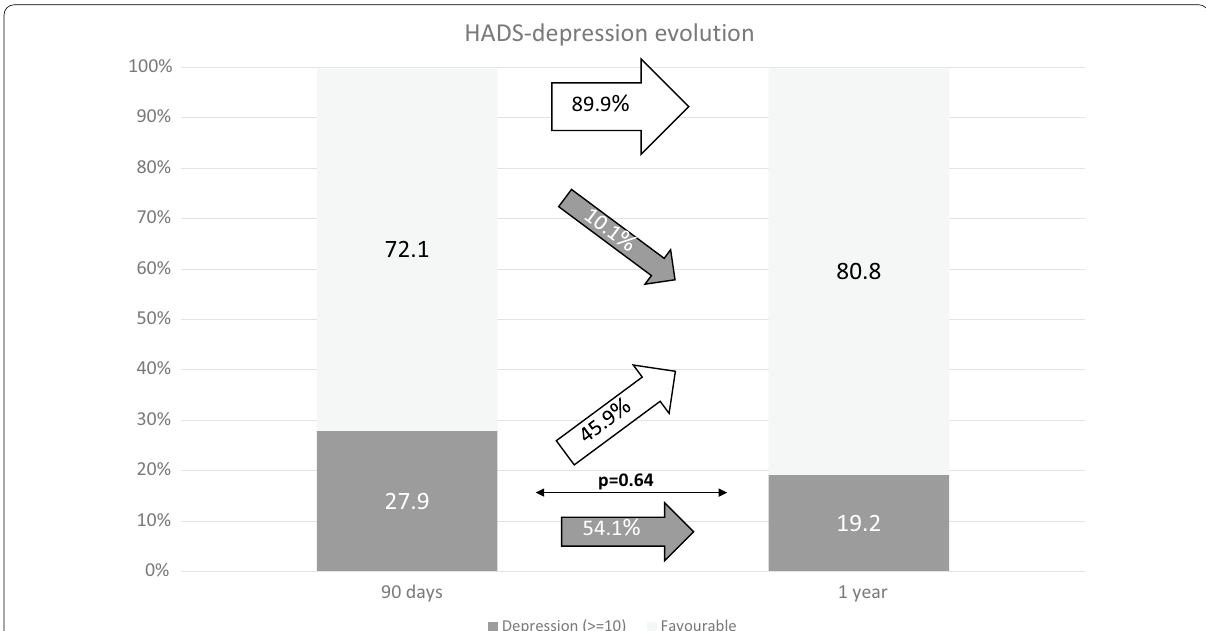
Fig. 4 Rate of favorable results in the depression items of HADS scale and depression diagnosed by HADS at different time‑points along follow‑up: 90 days and one year after stroke. The white arrows represent the rate of patients with improvement in the measured PROM or persistence of favorable outcome at the following time‑point of evaluation. The gray arrows represent impairment toward an unfavorable result in the measured PROM or unfavorable outcome persistence. Thin arrows represent statistical comparison of the rate of favorable/unfavorable outcomes as compared with the previous